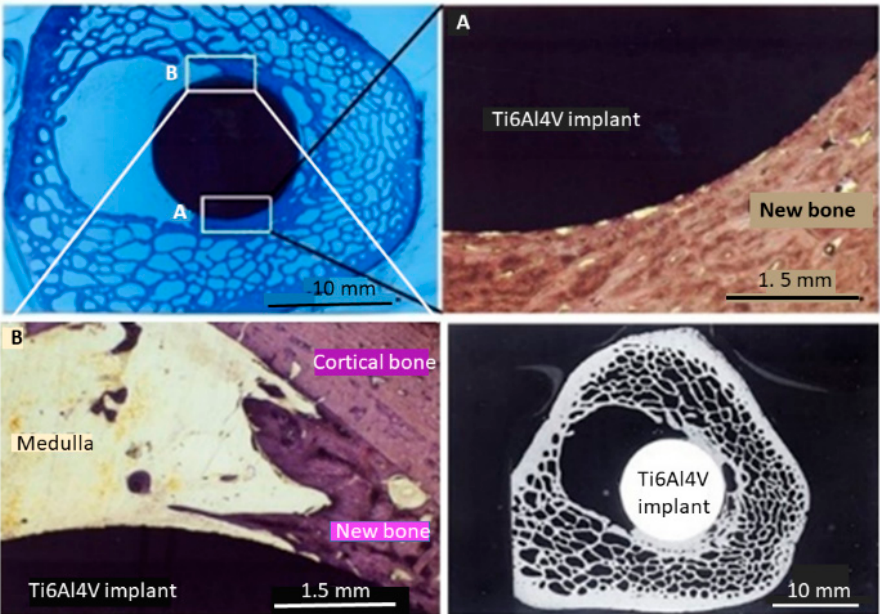
Figure 4. Formation of new bone in contact with a Ti6Al4V rod coated with a 150 µm thick plasma-sprayed layer of CTZ 3 P 3 and implanted into the femoral medulla of sheep [25,28]. Top left: Micrograph of a distal section stained with toluidine blue. Top right: Magnified view of area A, showing the tight and continuous apposition of newly formed bone. Bottom left: Magnified view of area B, showing an incomplete gap-filling potential when the distance between the implant and cortical bone is too large. Bottom right: Cross-sectional microradiographic image of the implant located in the femoral medulla of sheep. © With permission by Wiley-VCH.